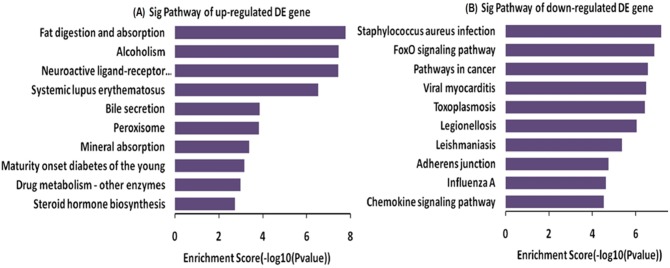
Pathway analysis of DEG.A: The bar plot showed the top ten up-regulated Enrichment Score values of the significant enrichment pathway; B: The bar plot showed the top ten down-regulated Enrichment Score value of the significant enrichment pathway.